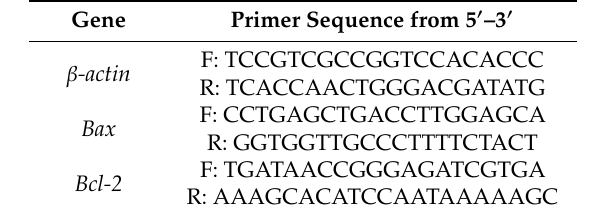
Table 3. Nucleotide sequences of the primers used for the analysis of mRNA expression by qRT-PCR. Gene Primer Sequence from 5 (cid:48) –3